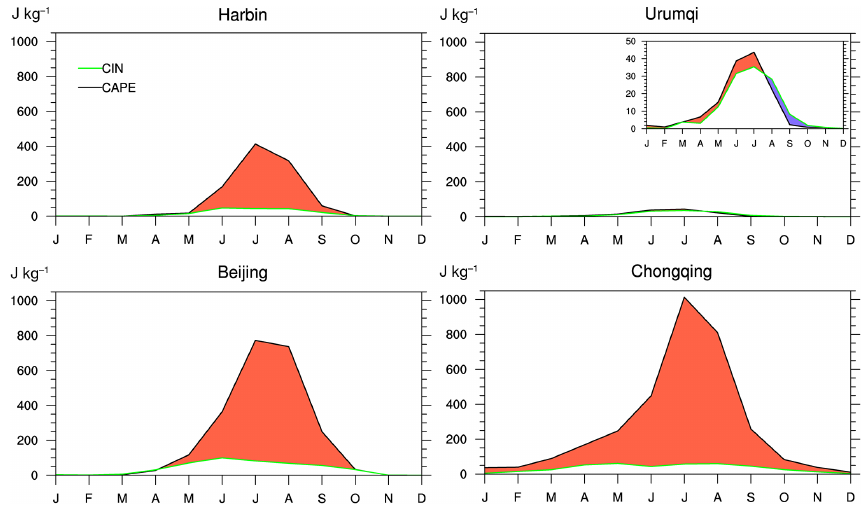
Figure 8. Annual cycle of CAPE (black line) and CIN (green line) values of four representative stations (Harbin, Urumqi, Beijing, and Chongqing). The orange filled area indicates values of CAPE with CIN deducted, i.e., real latent